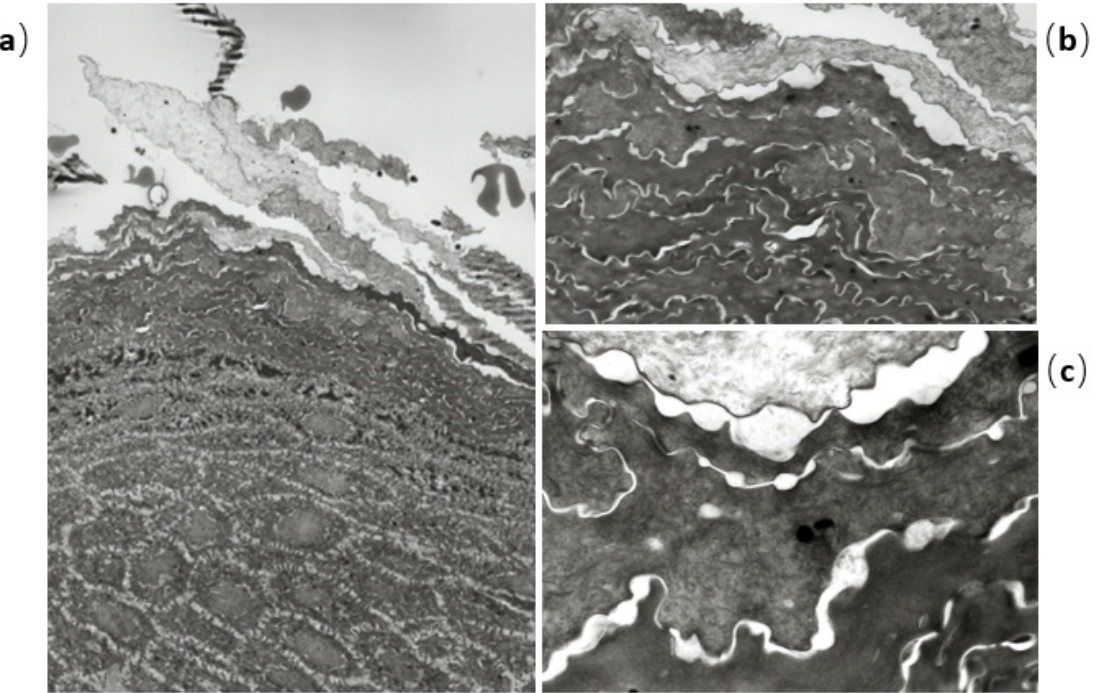
Figure 3. Electron microscopic findings show hyperkeratosis ( a ), deposition of intercellular lipoid cells ( b ), and normal cornified cell envelope ( c ).